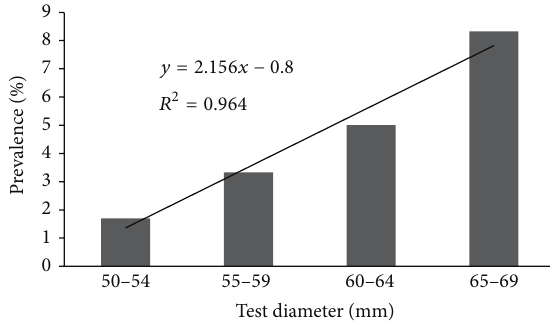
Figure 2: Anterior region of Lumbrineris latreilli .